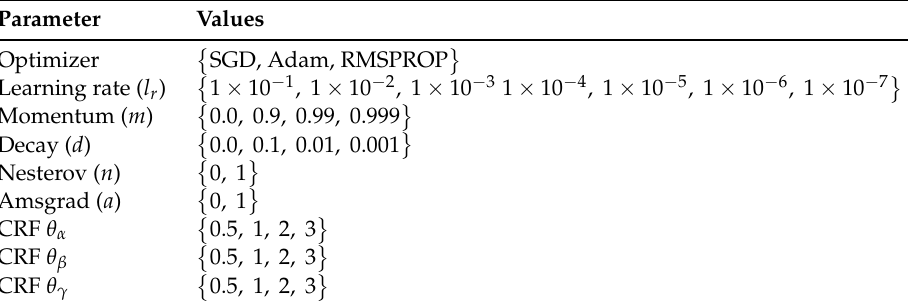
Table 4. List of the hyper-parameters considered in the grid search.